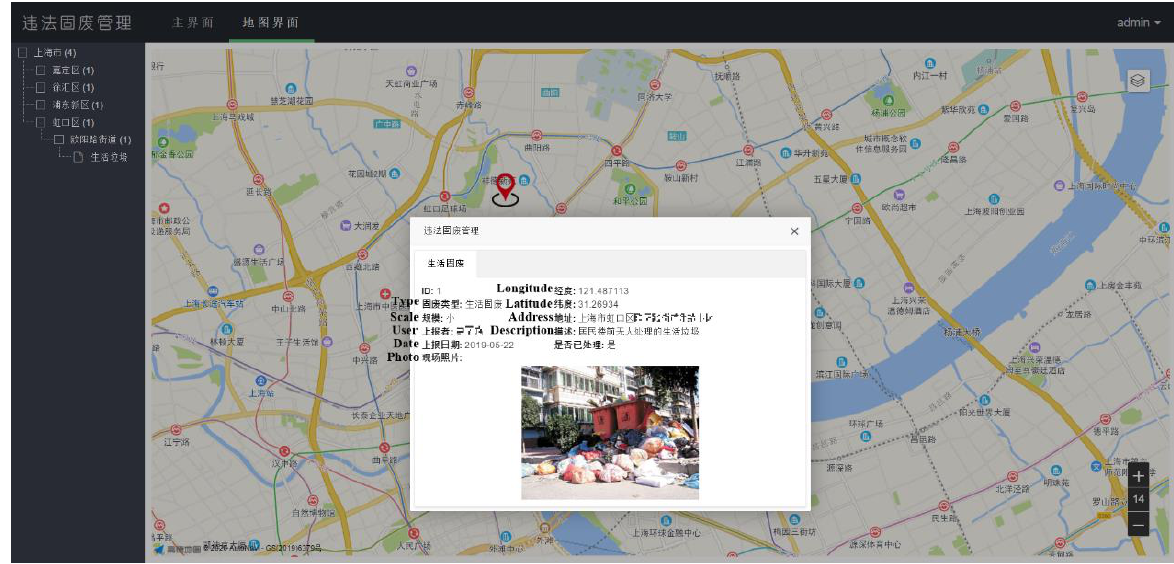
Figure 7. Display the detailed information of the illegal solid waste site on Gaode